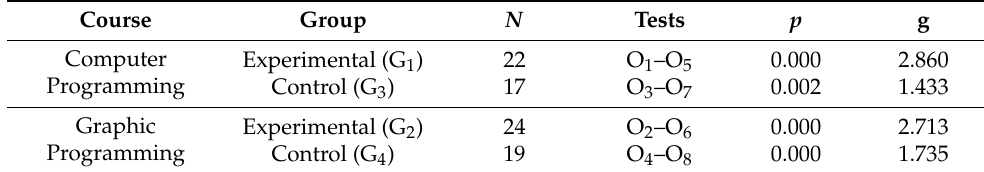
Table 15. Mann–Whitney U Test for post-tests vs.